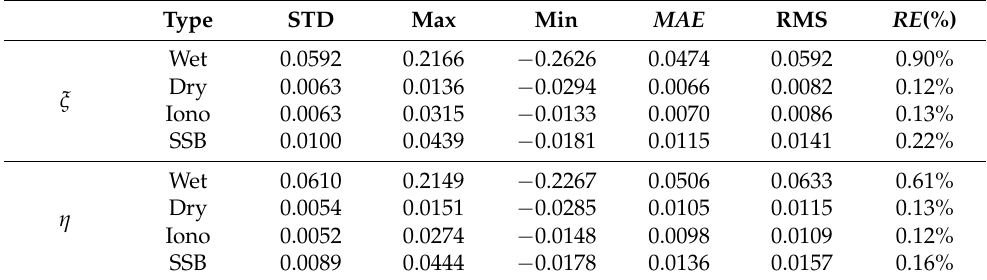
Table 3. The Influence of residual environmental errors on the recovery accuracy of DV (uint: arcsec).